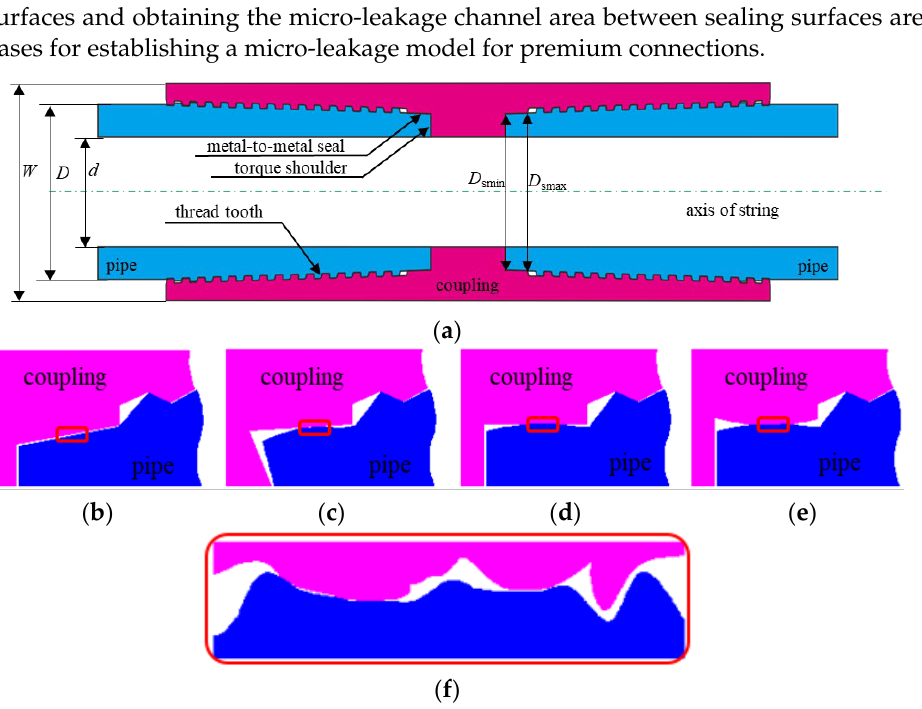
Figure 1. Seal structures and micro-leakage channels for tubing and casing premium connections. ( a ) Schematic diagram of premium connection; ( b ) cone-to-cone; ( c ) ball-to-cone; ( d ) ball-to-cylinder; ( e ) ball-to-ball; ( f ) schematic diagram of micro-leakage channel of sealing surface.